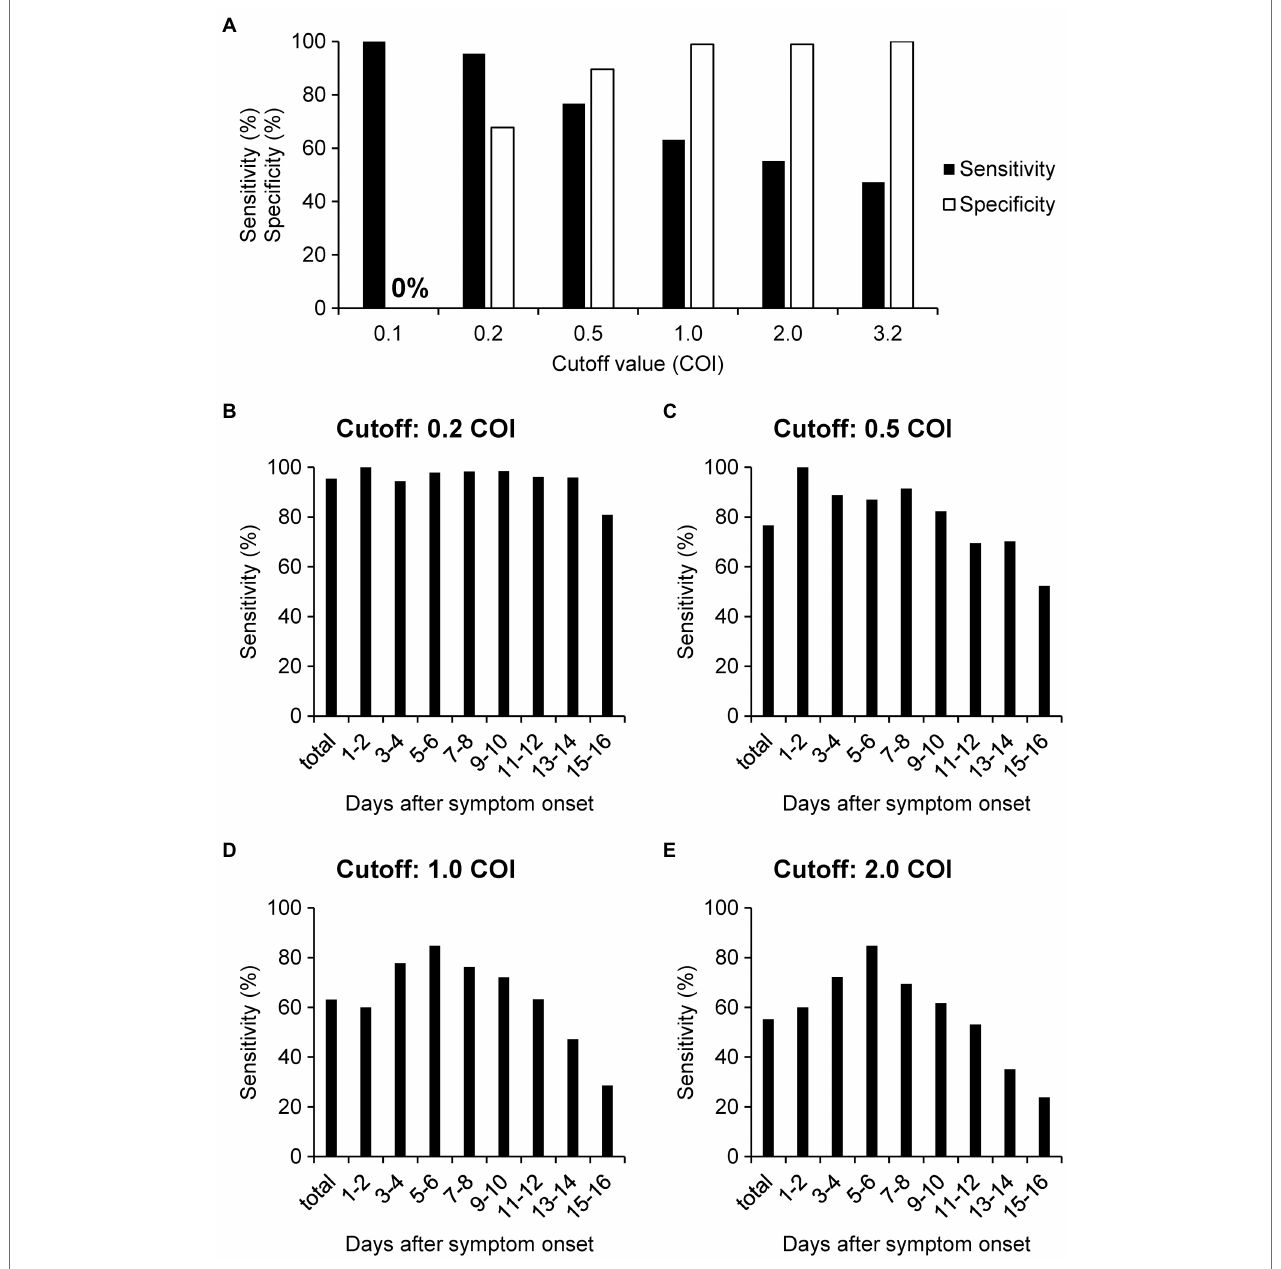
FIGURE 2 | Sensitivity and specificity of N antigen testing for the diagnosis of COVID-19. (A) We calculated the sensitivity and specificity using the serum samples of patients with non-COVID-19 cases ( n = 96) and COVID-19 ( n = 391), with the cutoff value set at 0.2, 0.5, 1.0, 2.0, or 3.2 COI. (B–E) We calculated the sensitivity for each time-point after symptom onset using serum samples collected from COVID-19 cases when the cutoff value was set at 0.2, 0.5, 1.0, and 2.0 COI. The numbers of samples at each time point are indicated in Supplementary Table S1